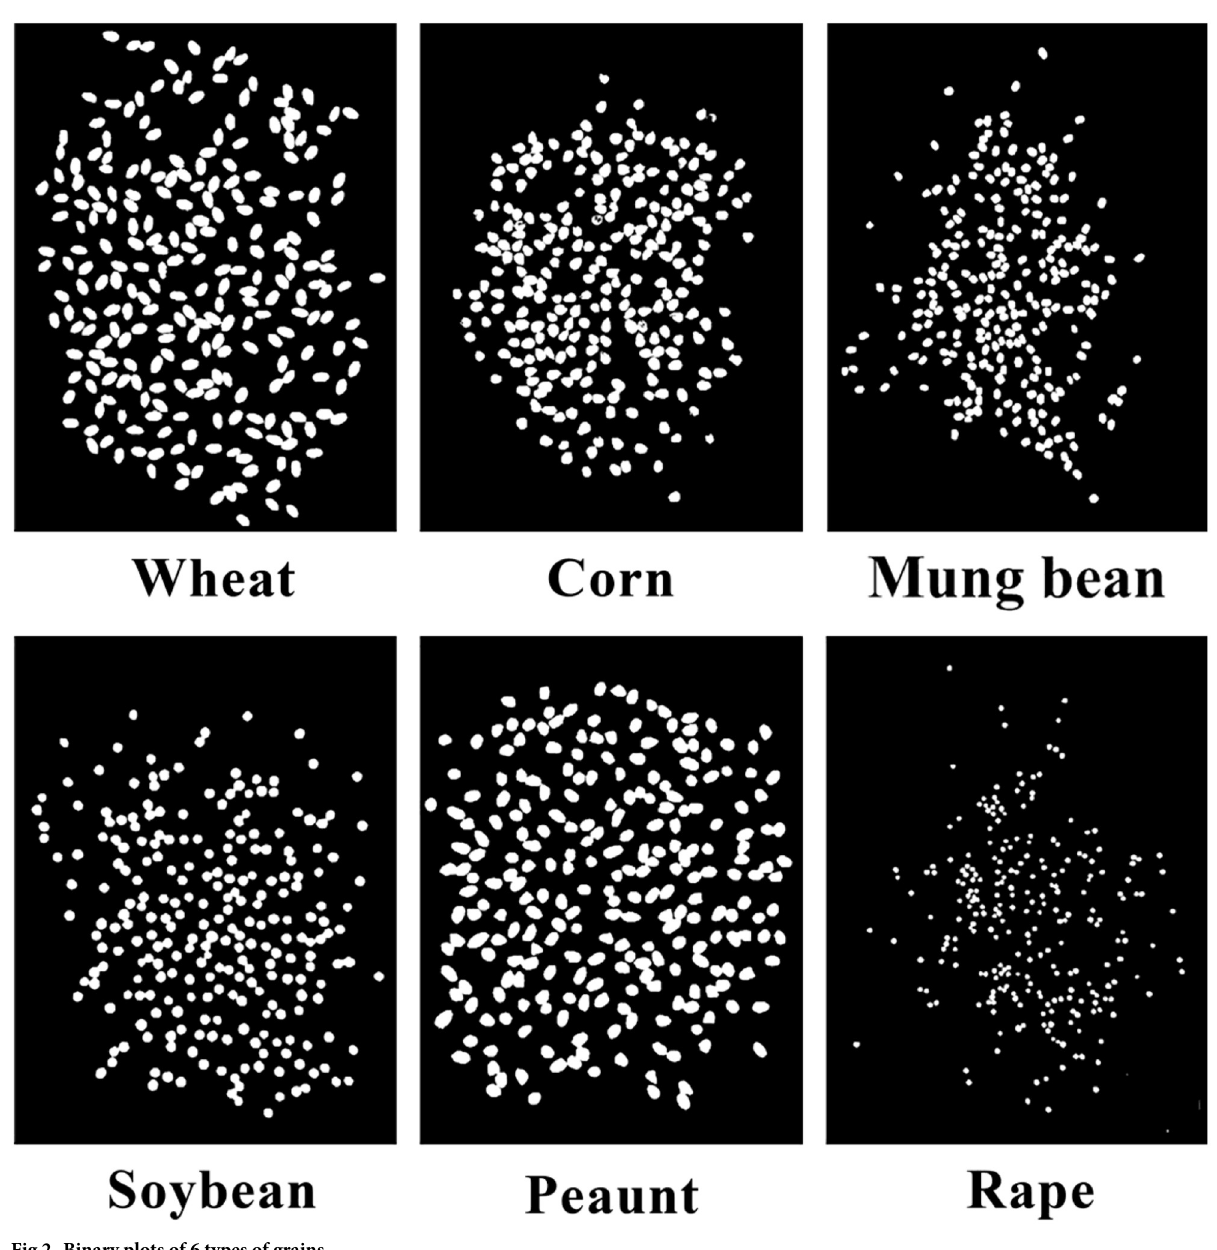
Fig 2. Binary plots of 6 types of